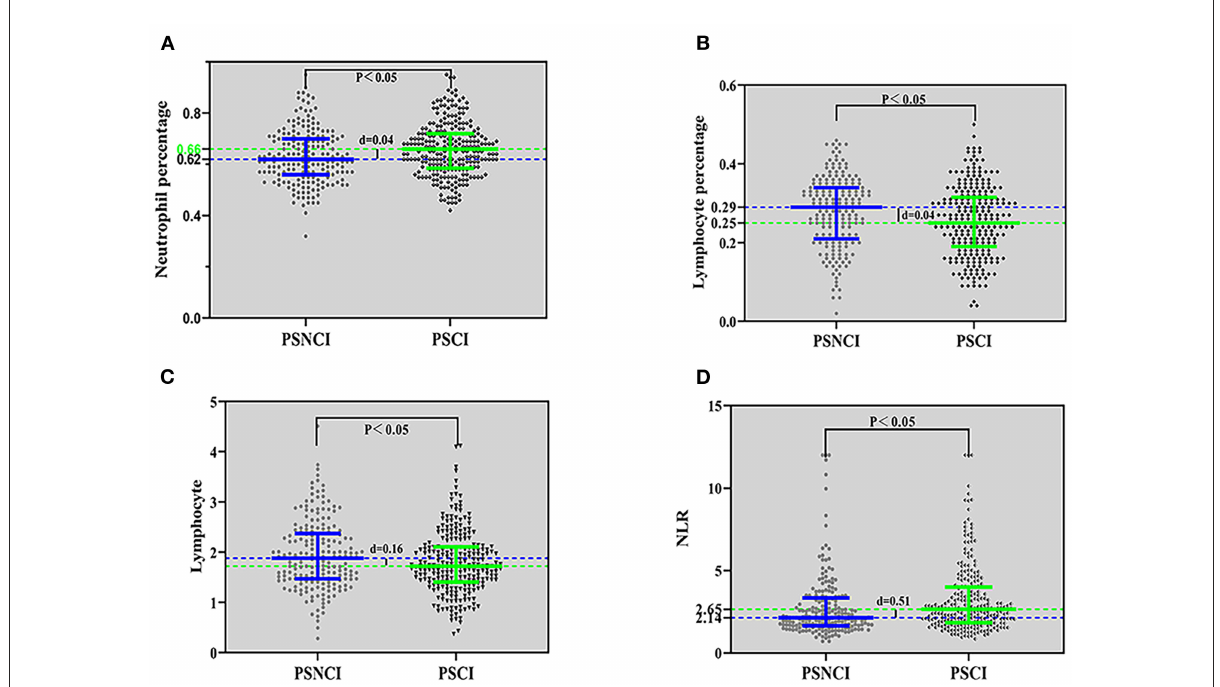
FIGURE2 Comparison of inflammatory indicators between the PSCI and PSNCI groups, based on the neutrophil percentage (A) , lymphocyte percentage (B) , lymphocyte (C) , and NLR (D) . PSCI, post-stroke cognitive impairment; PSNCI, post-stroke no cognitive impairment; NLR, neutrophil/lymphocyte